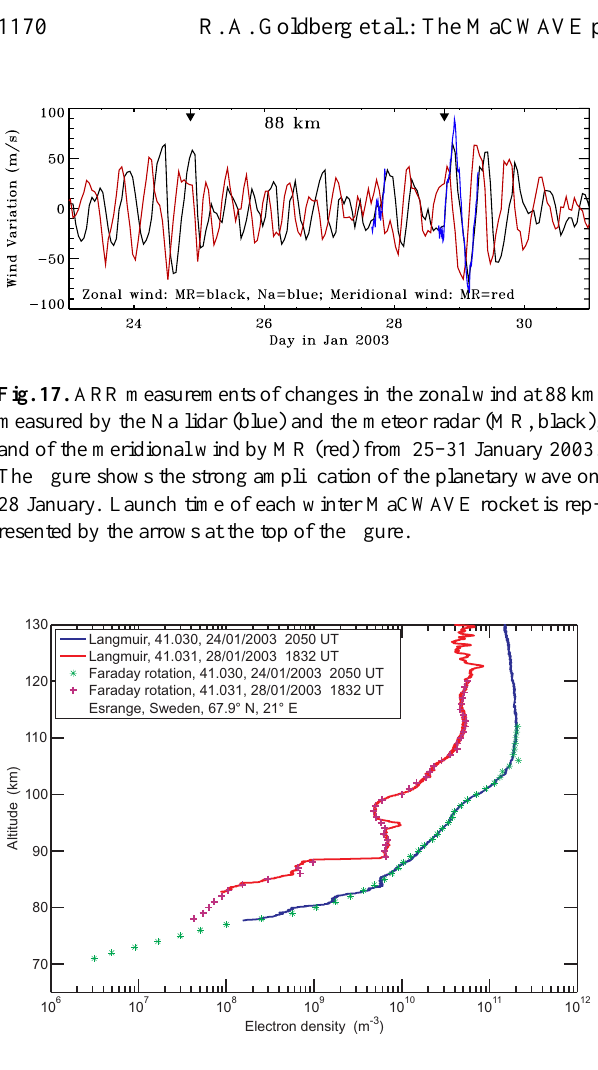
Fig. 18. Vertical profiles of electron density measured with the MaCWAVE rockets during the salvos on 24 January 2003 (blue) and 28 January 2003 (red). The absolute value of the detailed struc- ture was obtained by normalizing the Langmuir probe currents to the radio propagation electron density profiles.